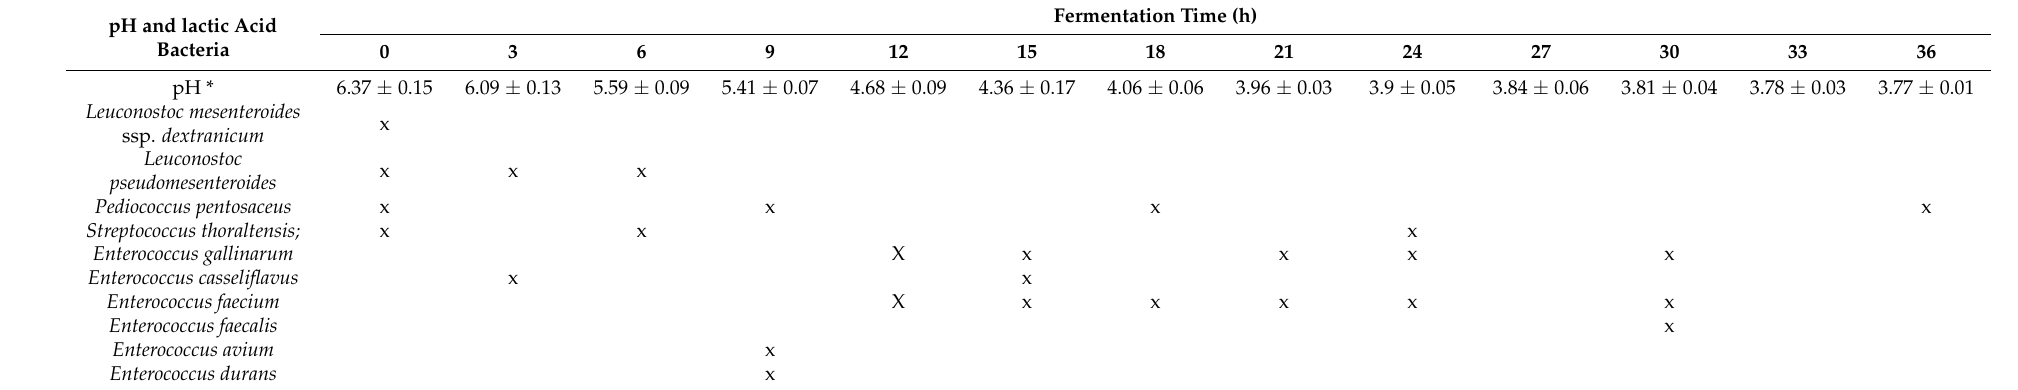
Table 4. Tentative lactic acid bacteria isolated at different times and pH during fermentation of pearl millet slurry. pH and lactic Acid